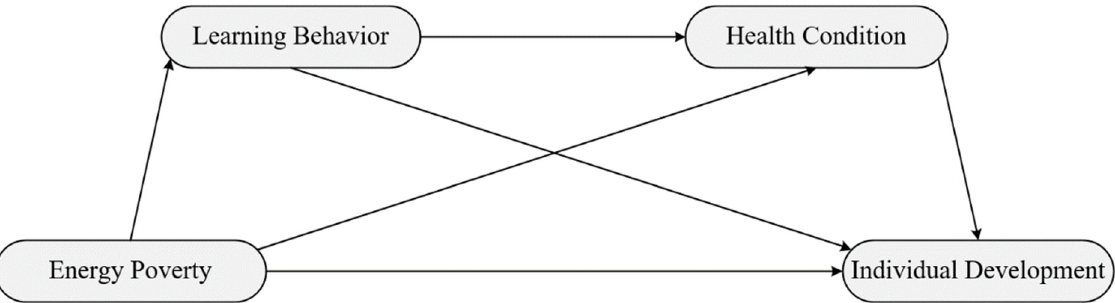
Figure 1. Serial mediation model.